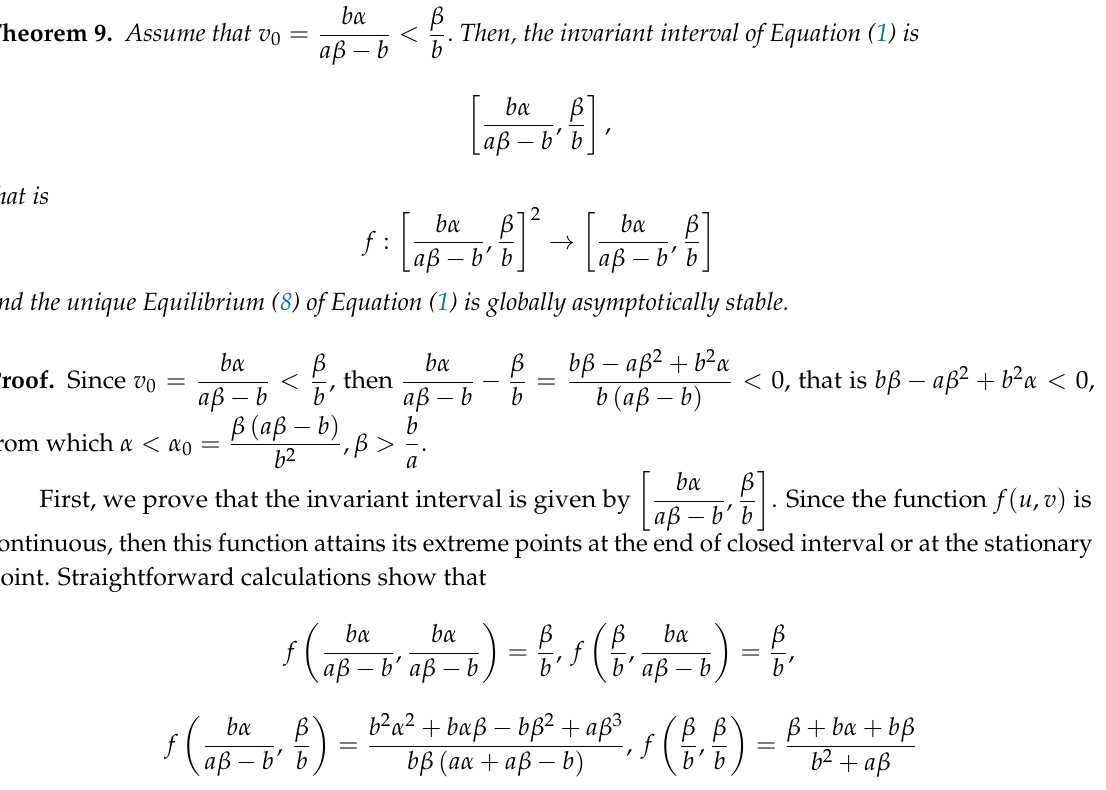
b α β < the following result a β − b b